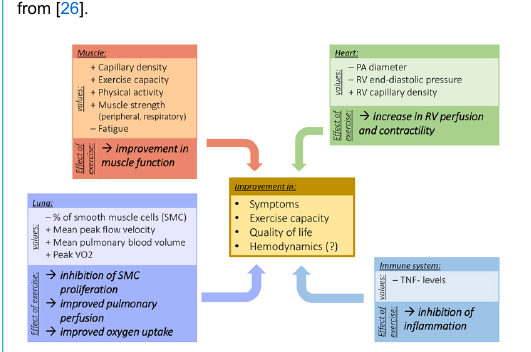
Figure 1: Effects of exercise training in PAH patients. Adapted from